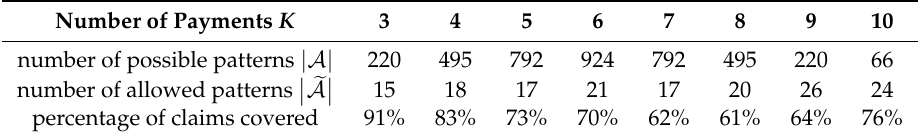
Table 1. Number of possible and allowed distribution patterns for K = 3, . . . ,10